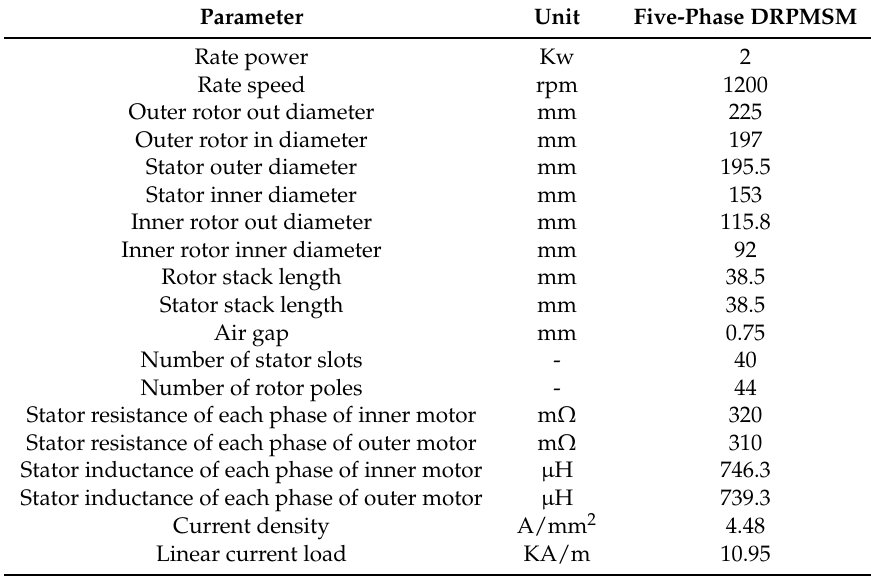
Table 14. Some of the design and electrical parameters of the DRPMSM in